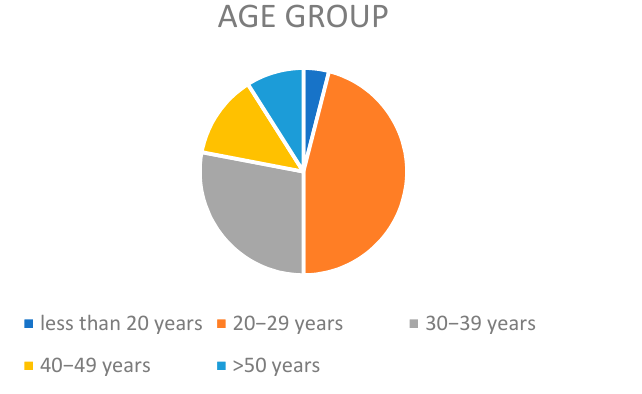
Figure 1. Distribution of respondents according to age.